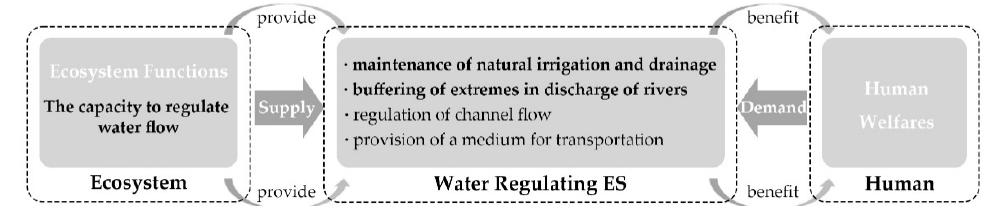
Figure 1. Conceptual framework linking ecosystem functions and human welfares as supply and demand sides of water regulating ES. demand sides of water regulating